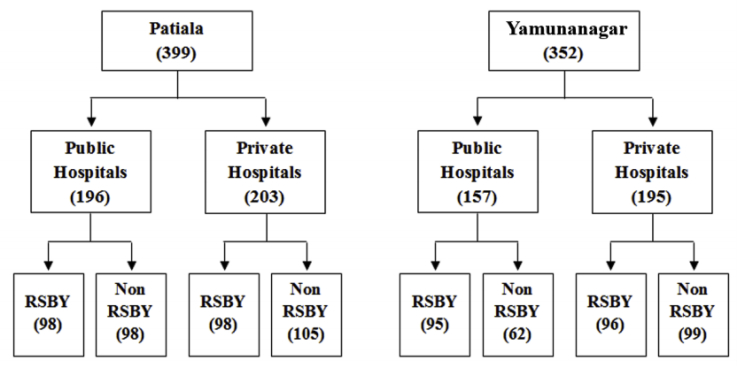
Exit interview sample size.